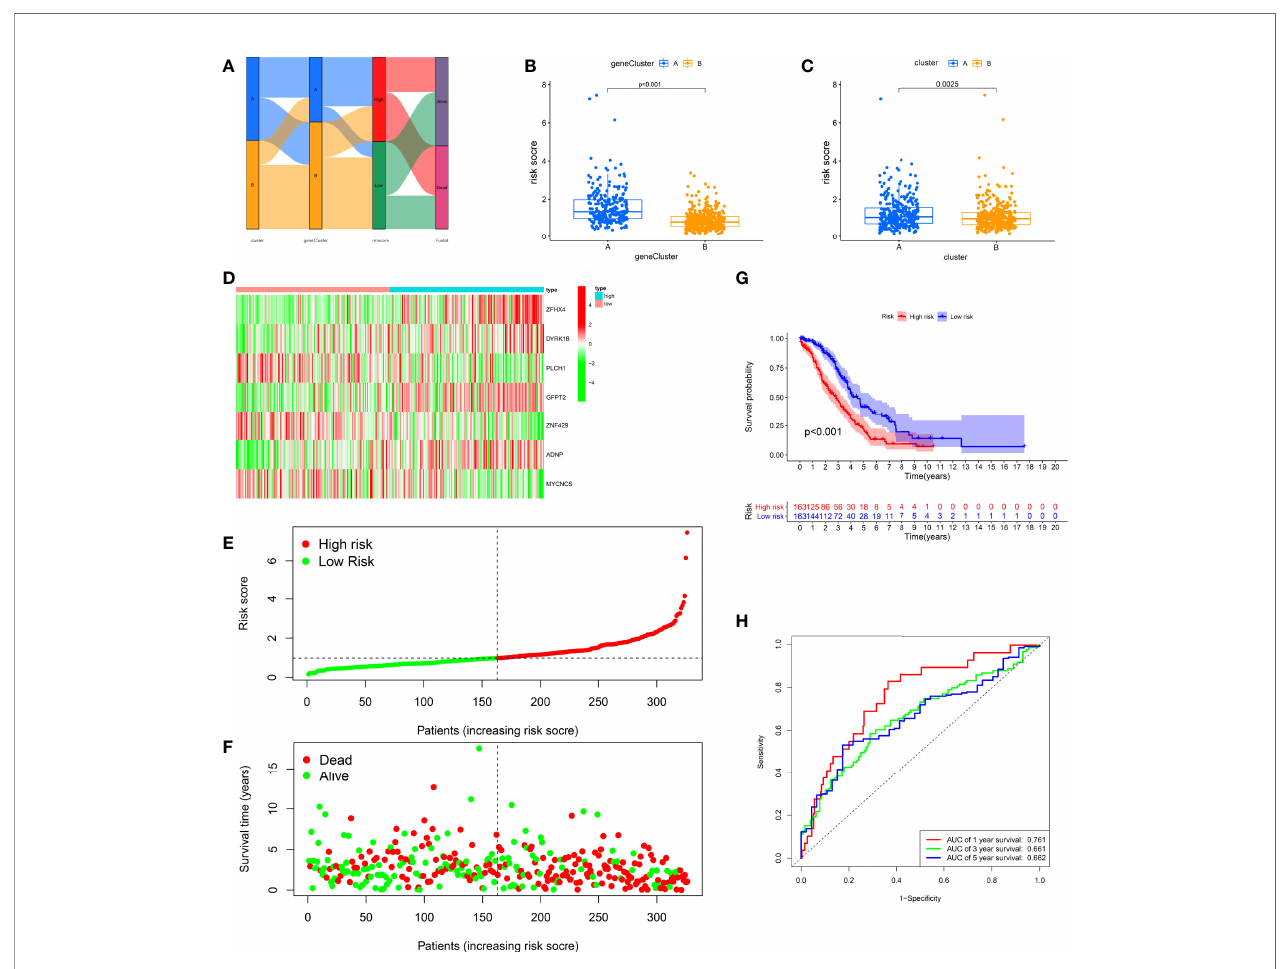
FIGURE 5 | Construction of the RMW score in the training set. (A) Alluvial diagram of subtype distributions in groups with different RMW scores and survival outcomes. (B) Differences in RMW score between gene clusters. (C) Differences in RMW score between RNA modi fi cation patterns. (D) Heatmap shows the distribution of core genes in models between normal and ovarian cancer (OC) tissues. (E) Ranked dot showing the RMW score distribution and patient survival status. (F) Scatter plots showing the RMW score distribution and patient survival status. (G) Kaplan – Meier analysis of the overall survival (OS) between the two groups. (H) Receiver operating characteristic (ROC) curves to predict the sensitivity and speci fi city of 1-, 3-, and 5-year survival according to the RMW